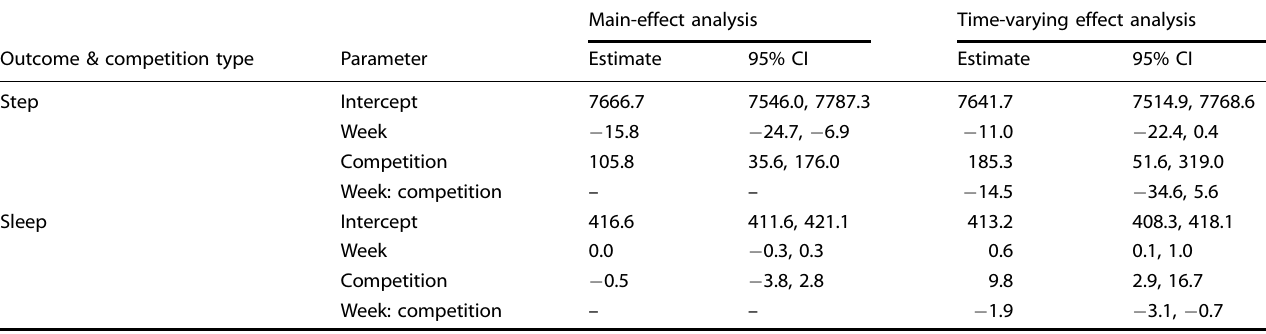
Table 2. Parameter estimates for linear models assessing marginal and time-varying causal effect of team competition on daily step count and sleep